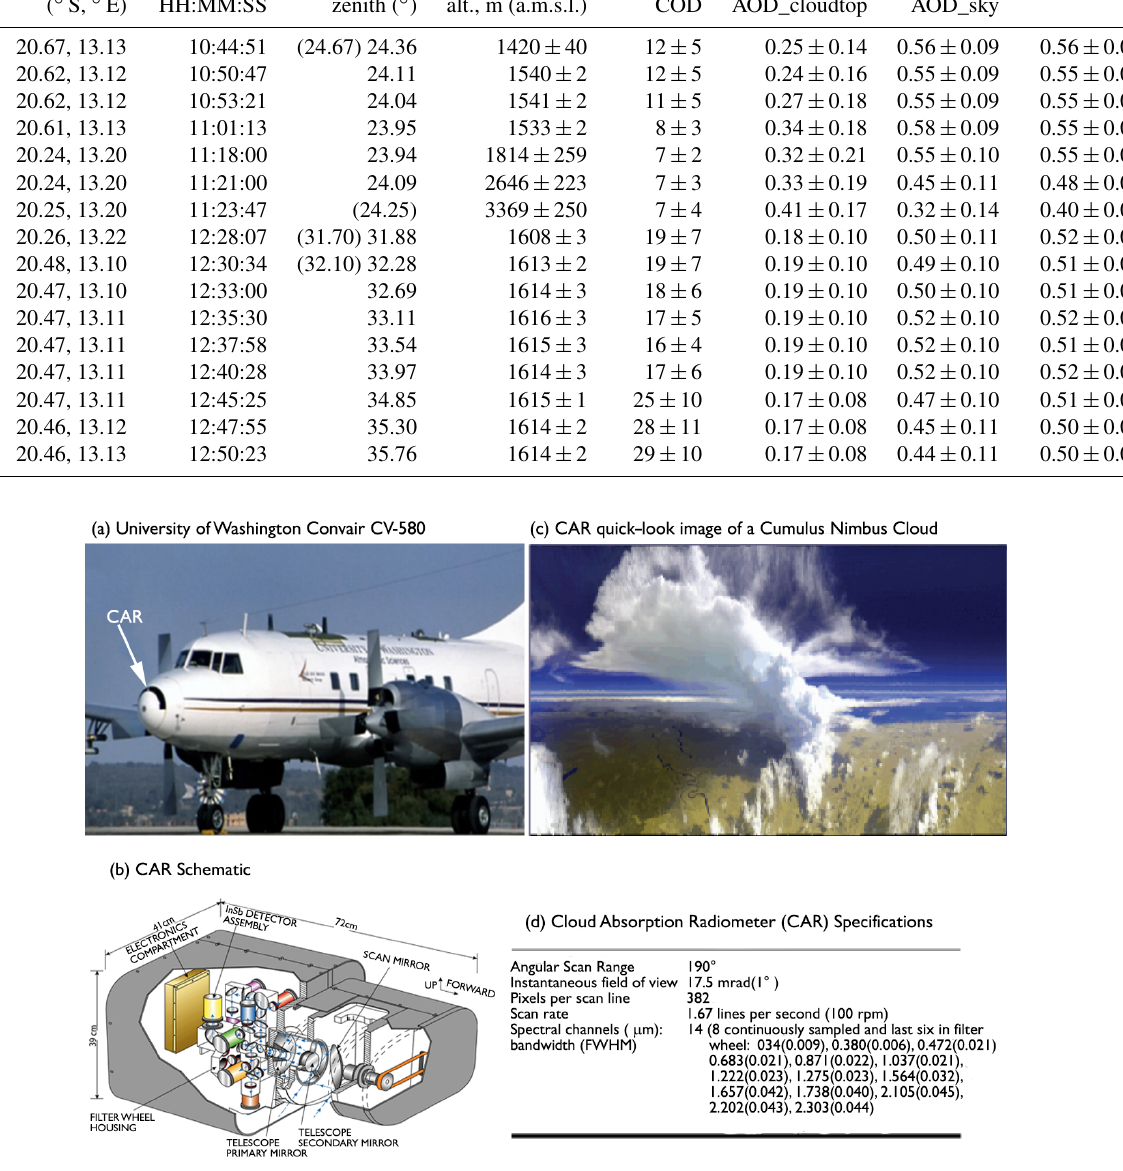
Figure 2. (a) The University of Washington’s Convair-580 research aircraft in Pietersburg, South Africa, for SAFARI 2000. (b) Schematic of NASA’s Cloud Absorption Radiometer (CAR), which was mounted in the nose of the CV-580 aircraft. (c) A cumulonimbus cloud observed with CAR during flight no. 2034 on 14 September 2011 at 18:35–18:40UTC in Florida to illustrate the kind of images acquired by CAR. (d) Specifications for the CAR, which contains 14 narrow spectral bands between 0.34 and 2.30µm.